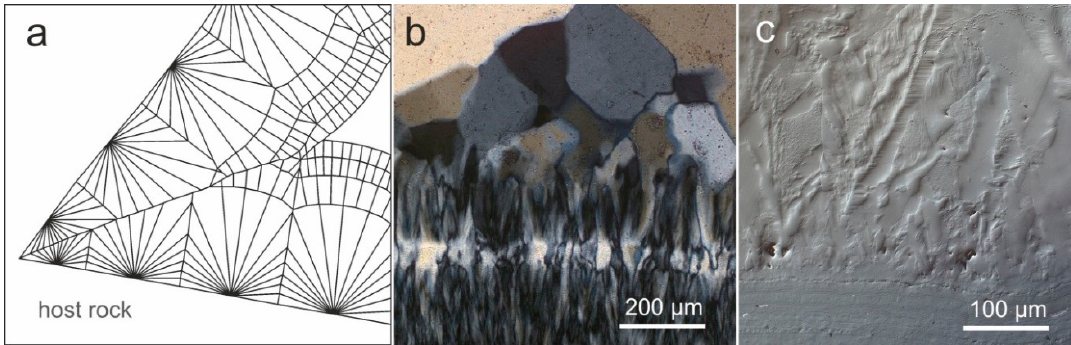
Figure 29. ( a ) Scheme of the formation of agate banding starting with separate spherulites and continuing inwards with fibrous chalcedony layers; ( b ) micrograph in transmitted light (crossed polars) of an agate from Los Indios (Cuba) showing a smooth transition from fibrous chalcedony to macrocrystalline quartz; ( c ) Nomarski DIC micrograph of the interface chalcedony/quartz revealing skeletal growth and irregular internal textures of macrocrystalline quartz, which point to rapid crystallization under non ‐ equilibrium conditions.